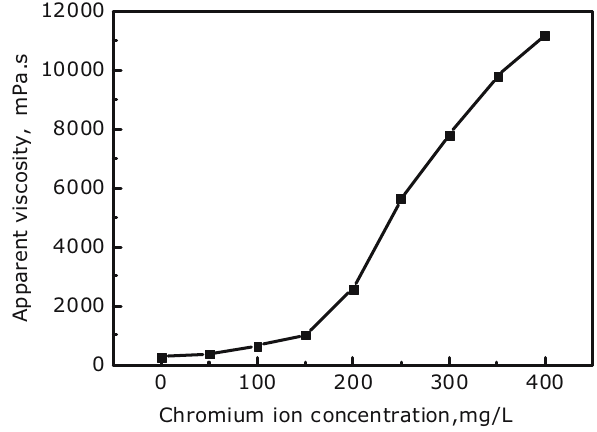
Figure 5: Curve of viscosity vs chromium ion concentration after the gelling of polymer